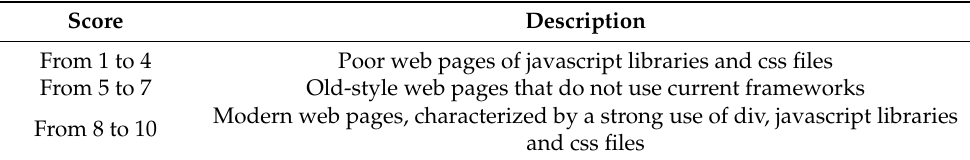
Table 2. Web page preliminary scoring.